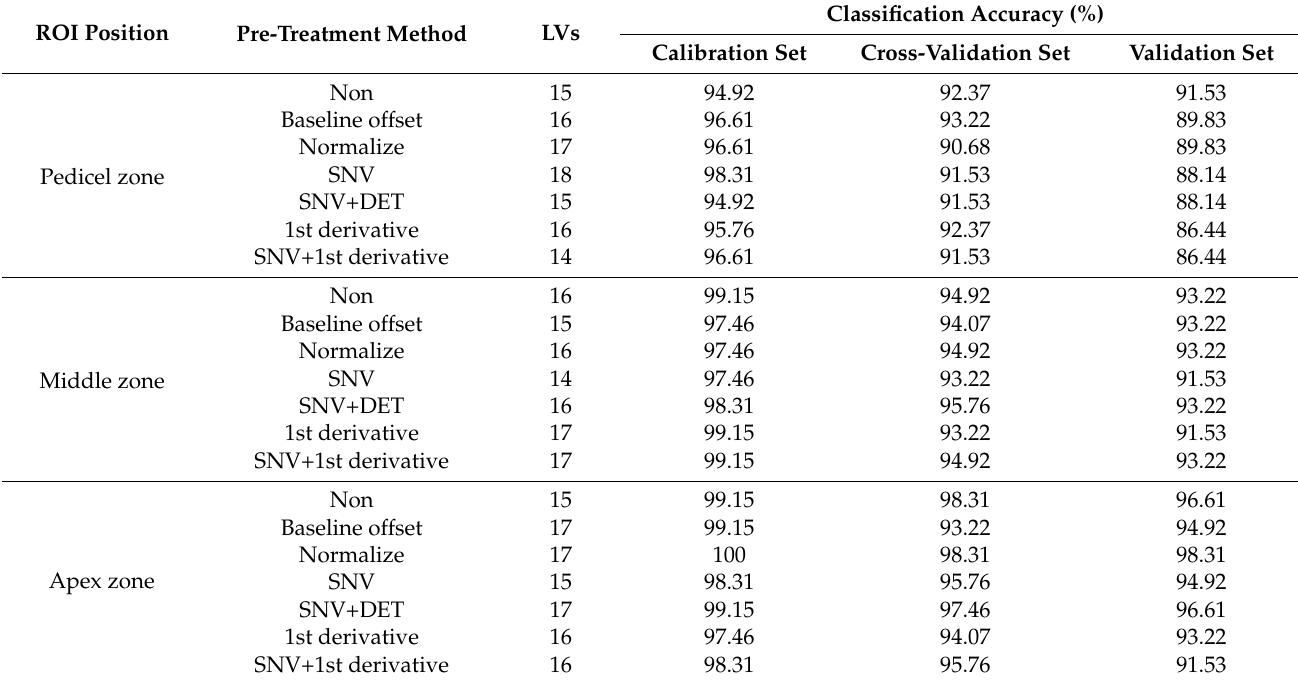
Table 2. Classification results of PLSDA models built with raw and pretreated spectra.